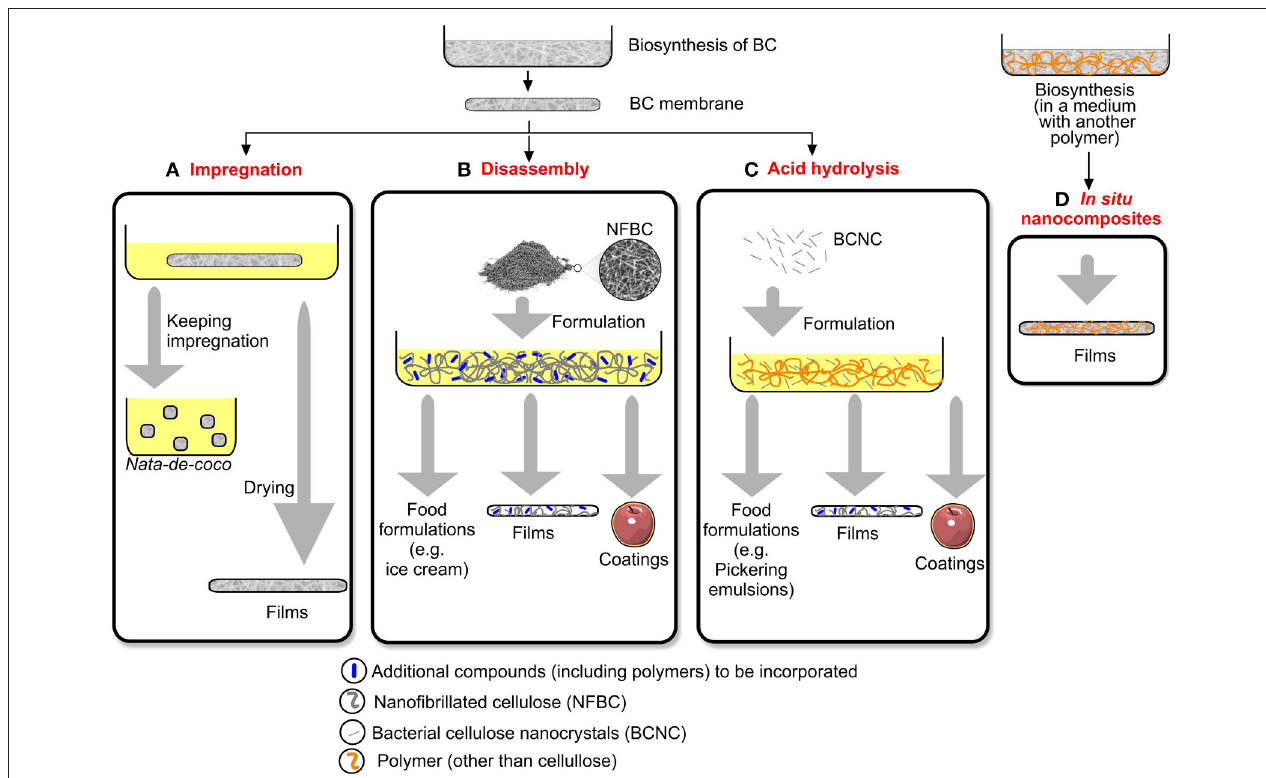
FIGURE 2 | Techniques to mix BC with other components for food and food packaging applications. (A) Impregnation; (B) Disassembly; (C) Acid hydrolysis; (D) In situ nanocomposites. (Adapted from: Azeredo et al., 2017; reproduced with the permission of